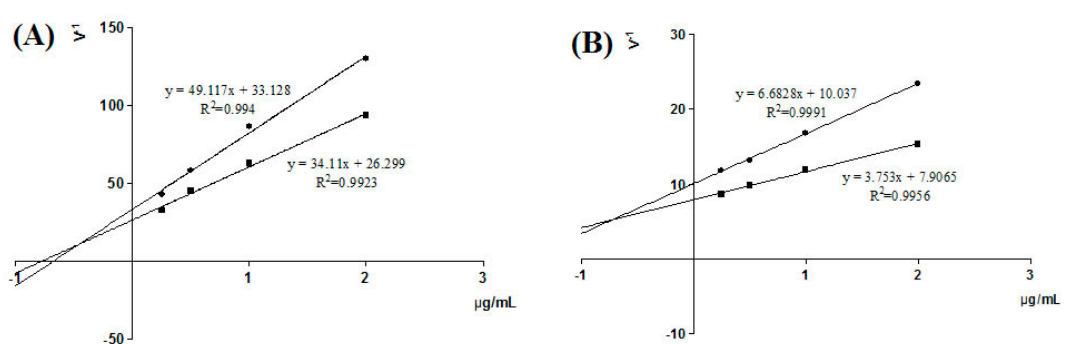
Figure 5. Inhibitory effect of luteolin-4 ′ - O -glucoside ( A ) and luteolin ( B ) on xanthine oxidase. ● xanthine 100 µmol/L ■ xanthine 200 µmol/L.